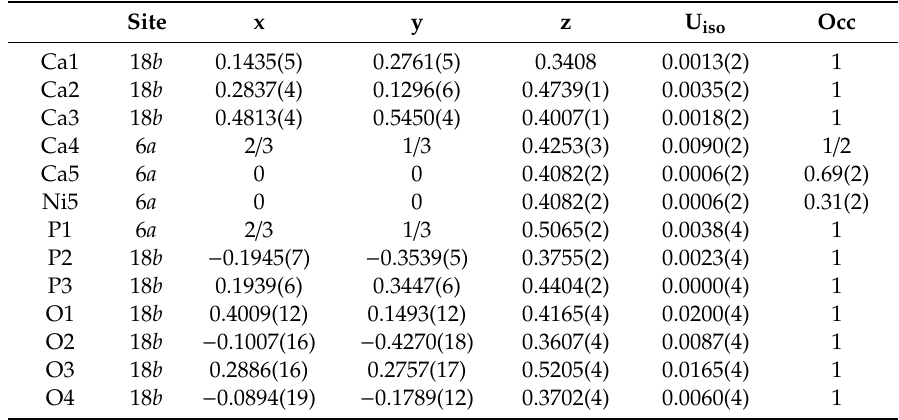
Table 3. Refined fractional atomic coordinates, Wycko ff site, isotropic displacement atomic parameters, and occupancy factors for Ca 2.9 Ni 0.1 (PO 4 ) 2